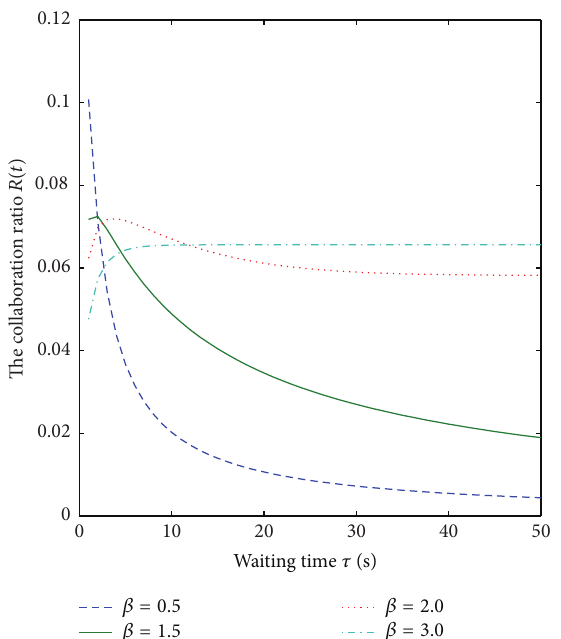
Figure 6: The collaboration ratio of groups with different predators.